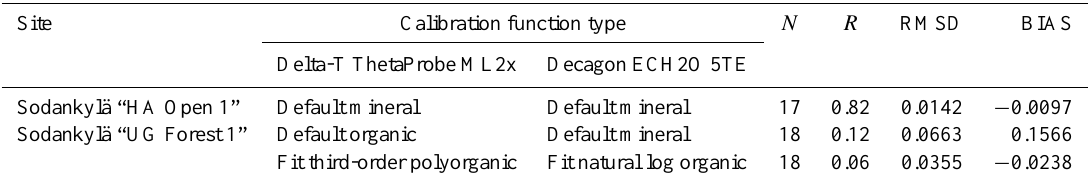
Table 7. Statistics for comparison of 0–5cm volumetric moisture content ( θ ) estimates by means of Delta-T ThetaProbe and Decagon 5TE sensors at the Sodankylä “HA Open 1” (low organic mineral soil, SOM = 6.89%) and “UG Forest 1” (organic substrate, SOM = 36.59%) network stations during summer 2012, using calibration functions as indicated below. N is the number of sampling points, R is Pearson’s correlation coefficient, RMSD is bias-corrected root mean square deviation, and BIAS is